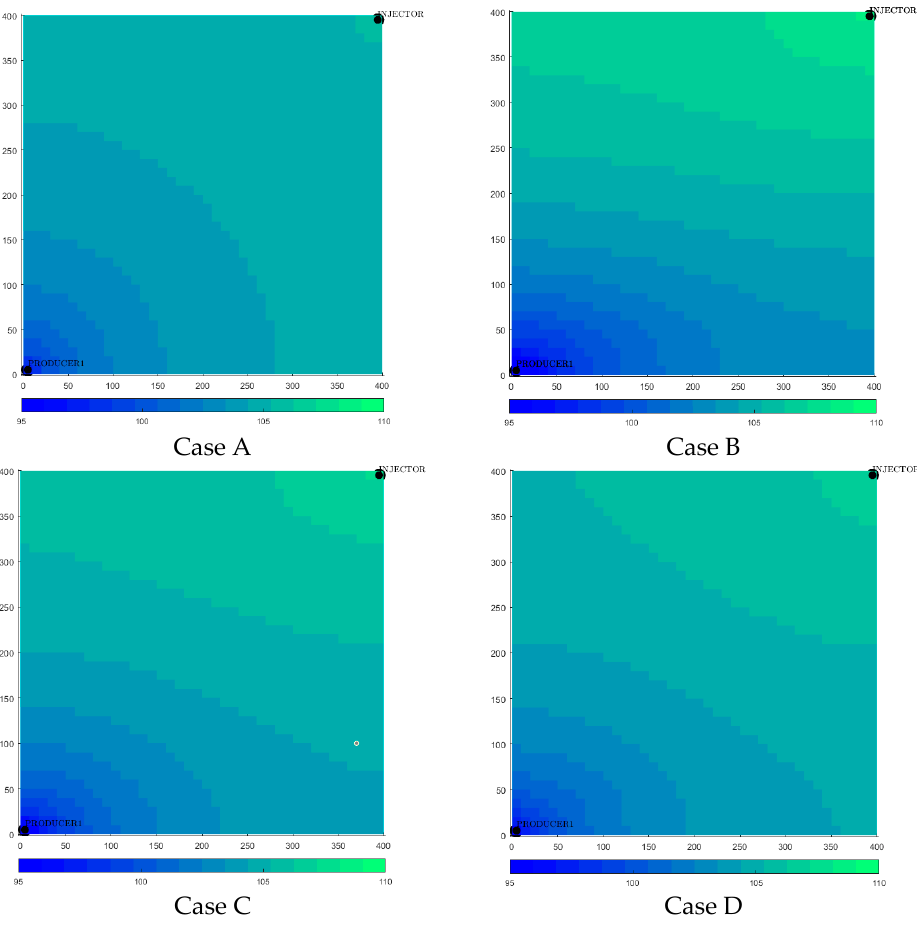
Figure 4. The pressure distribution of the four cases at the 50th time